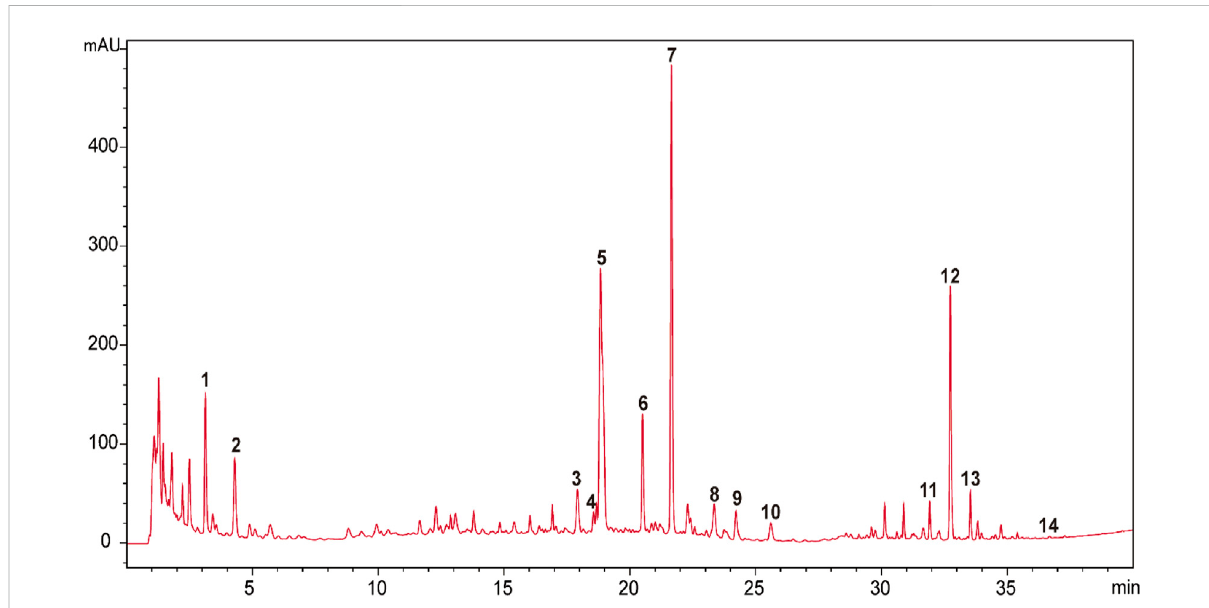
FIGURE 1 HPLC-UVD fi ngerprint of BZYQT. 1. (3R)-2,3-dihydro-3,5-dihydroxy-6-methyl-4(4H)-pranone; 2. 5-hydroxymethylfurfural; 3. ferulic acid; 4. neoliquiritin; 5. liquiritin; 6. narirutin; 7. hesperidin; 8. lobetyolin; 9. ononin; 10. cimicifugic acid F; 11. formononetin; 12. 18 β -glycyrrhizic acid; 13. uralsaponin B; 14. Z-ligustilide. Analysis conditions: Agilent 1200 HPLC equipped with a UVD detector was used as an analytic system. Column and temperature: Poroshell 120 EC-C18 (4.6 mm × 100 mm, 2.7 μ m), 40 ° C; mobile phases: water (A) and acetonitrile (B) (both containing 0.1% formic acid); fl ow rate: 1 ml/min; injection volume: 5 μ l; detection wavelength: 280 nm (0 – 24 min) and 254 (24 – 40 min); elution program